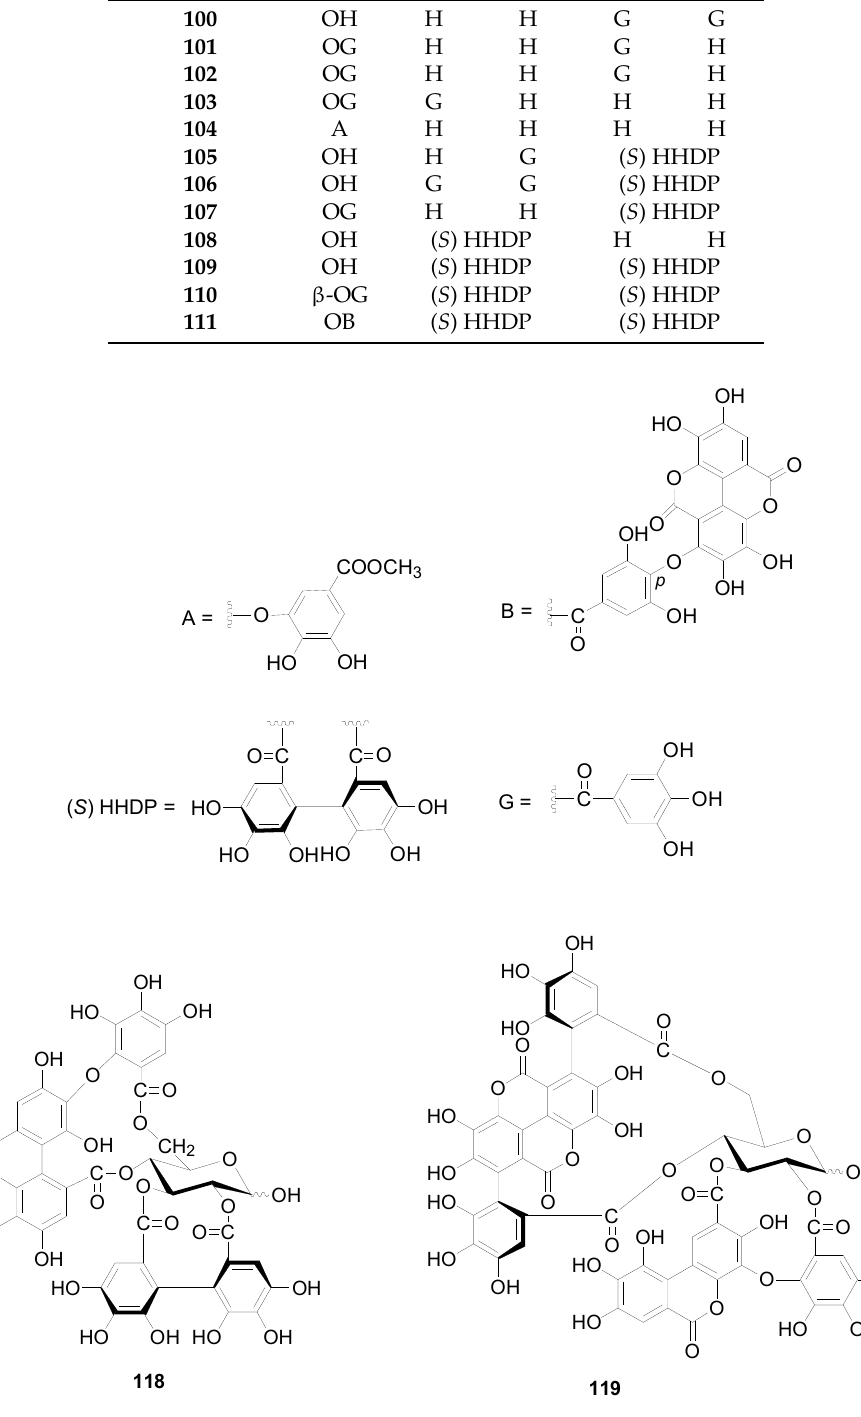
Figure 5. Structures of compounds 118 and 119 .